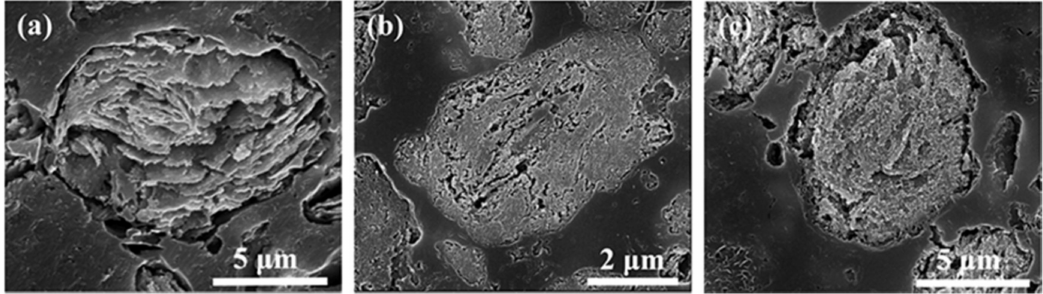
Figure 4. Cross-section morphologies of Al-7Zn-2.5Cu-2.5Mg milled powders at di ff erent ball milling time ( a ) P10, ( b ) P20 and ( c )